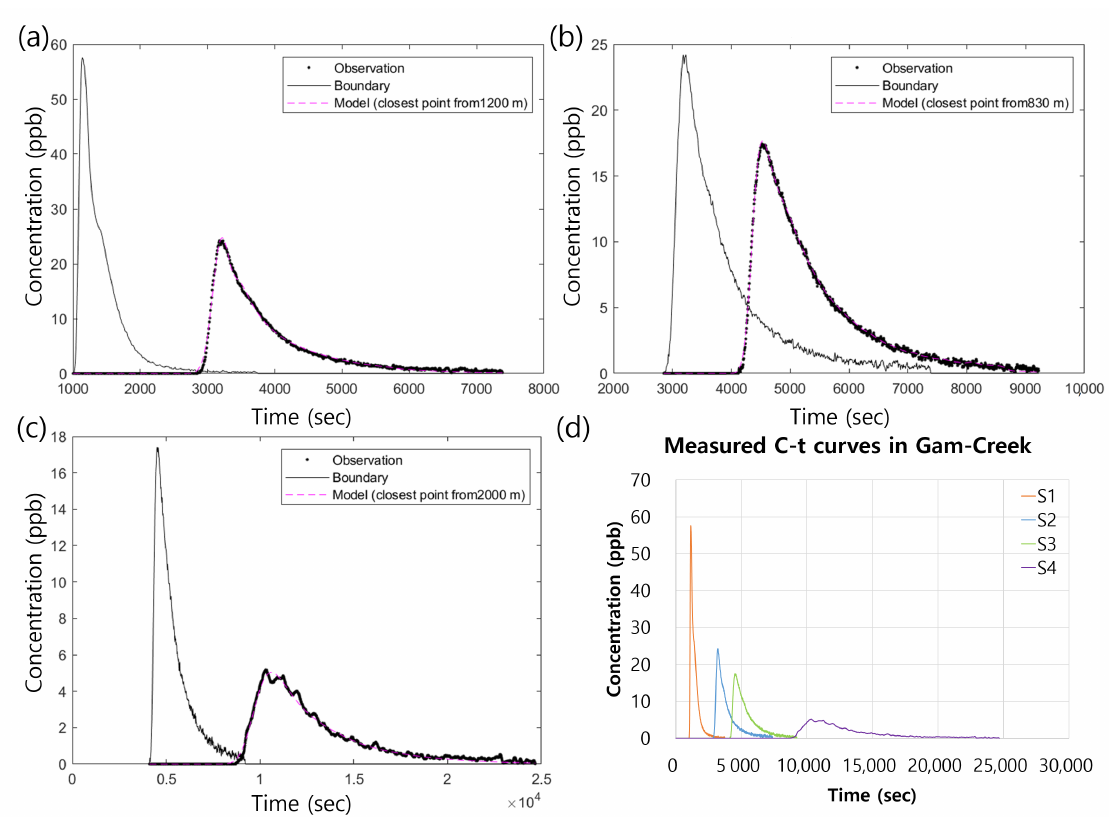
Figure A2. Observed BTCs in Gam-Creek tracer test and calibrated BTCs; ( a ) section 1–2. ( b ) section 2–3. ( c ) section 3–4. ( d ) All stations (only meausred